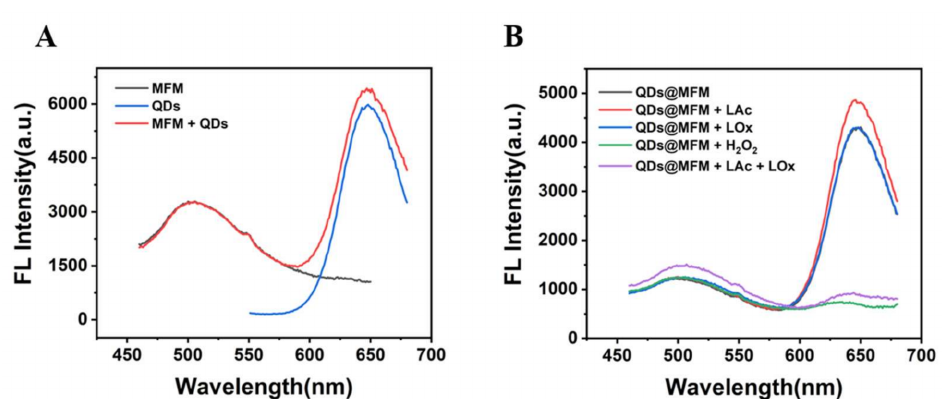
Figure 3. Feasibility test of Alg@MFM@QDs-LOx MSs used for lactate detection. ( A ) Fluorescence spectra of MFMs, QDs and MFMs + QDs. ( B ) Fluorescence spectra of the CdTe QDs and MFMs mixed solution with tris buffer solution, LOx, LAc (pH 8.2), H 2 O 2 , and LAc + LOx (pH 8.2). LAc: 1 mM, LOx: 0.06 U/mL, H 2 O 2 : 1